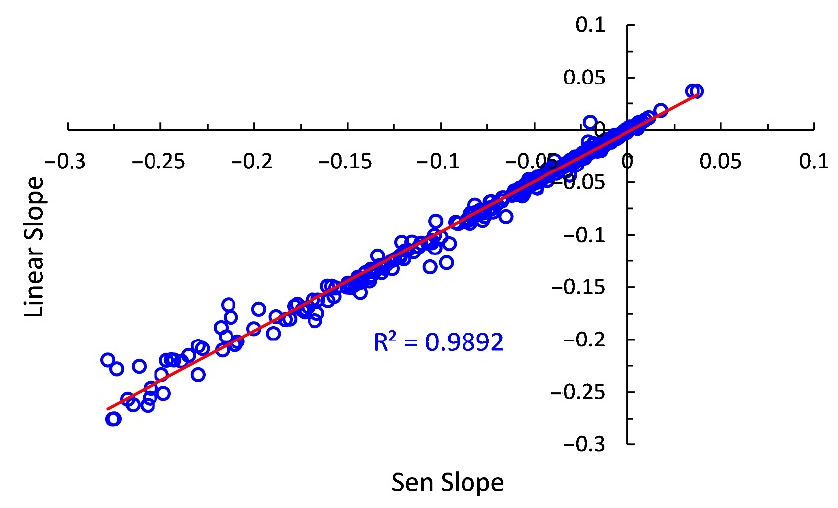
Figure 9. Results of the linear slope and Sen’s slope.